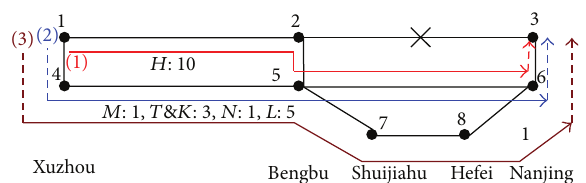
Figure 5: Solution of the train paths distributing model shown on the railway network